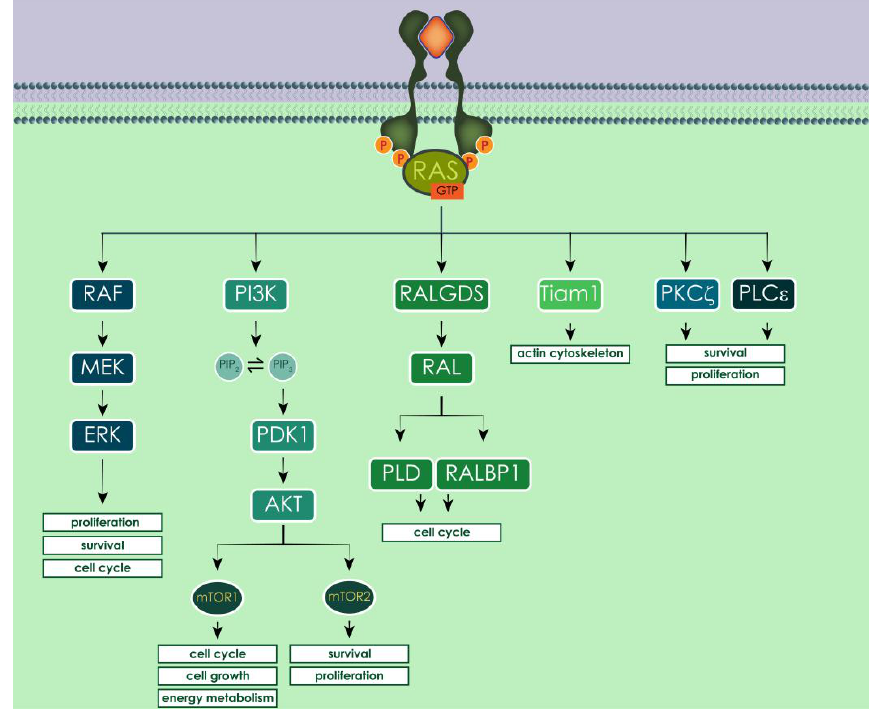
Figure 7. Activated human RAS proteins can activate multiple effectors, having different impact on cell fate. Among the most studied, activated RAF triggers pro-growth signaling through the MAP kinases cascade; PI3K leads to AKT activation and RALGDS stimulated cell cycle progression.